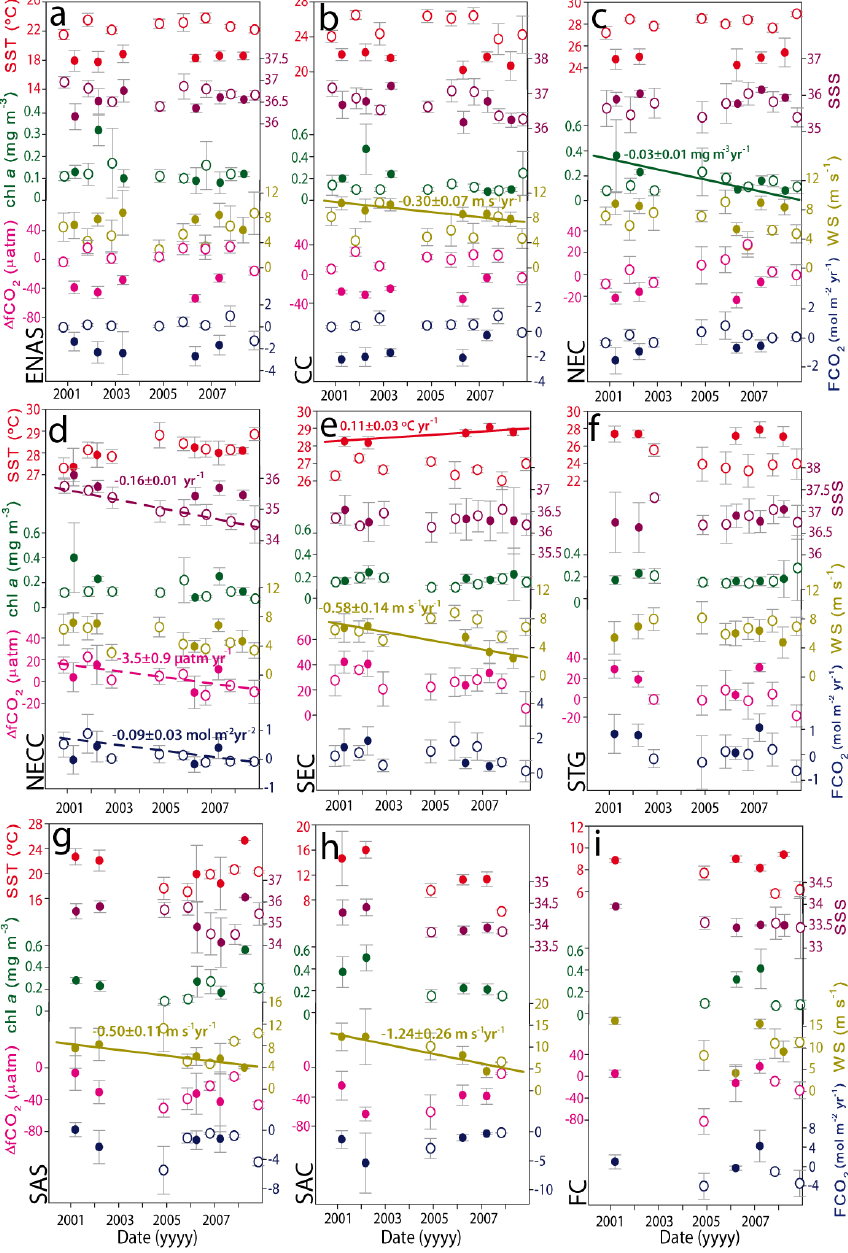
Fig. 4. Temporal variation of the averaged SST, SSS, chl a , WS, 1f CO 2 and F CO 2 cruise (error bars stand for the respective standard deviation) in each of the selected biogeochemical provinces. Spring and autumn values are shown as dark and open circles, respectively. Significant regression lines ( p < 0.05) and regression slopes including the standard error are also given. Solid lines stand for spring results and dashed lines for